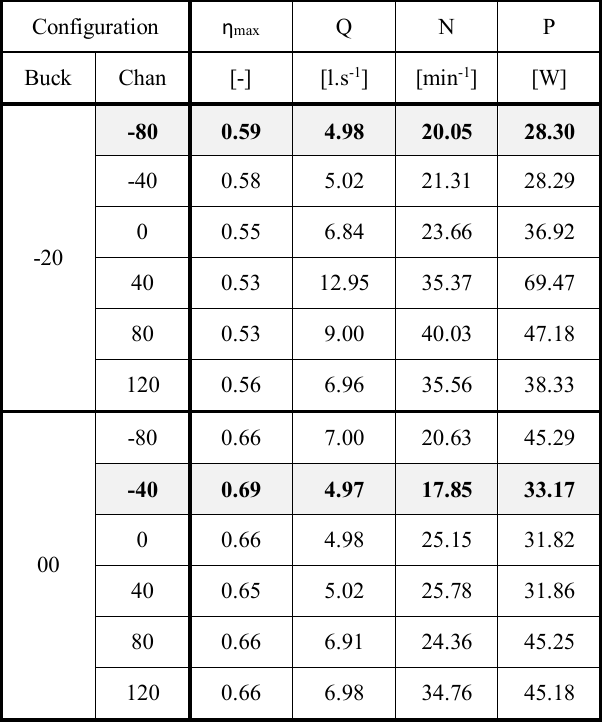
Table 2. Basic parameters for maximal efficiency obtained at each